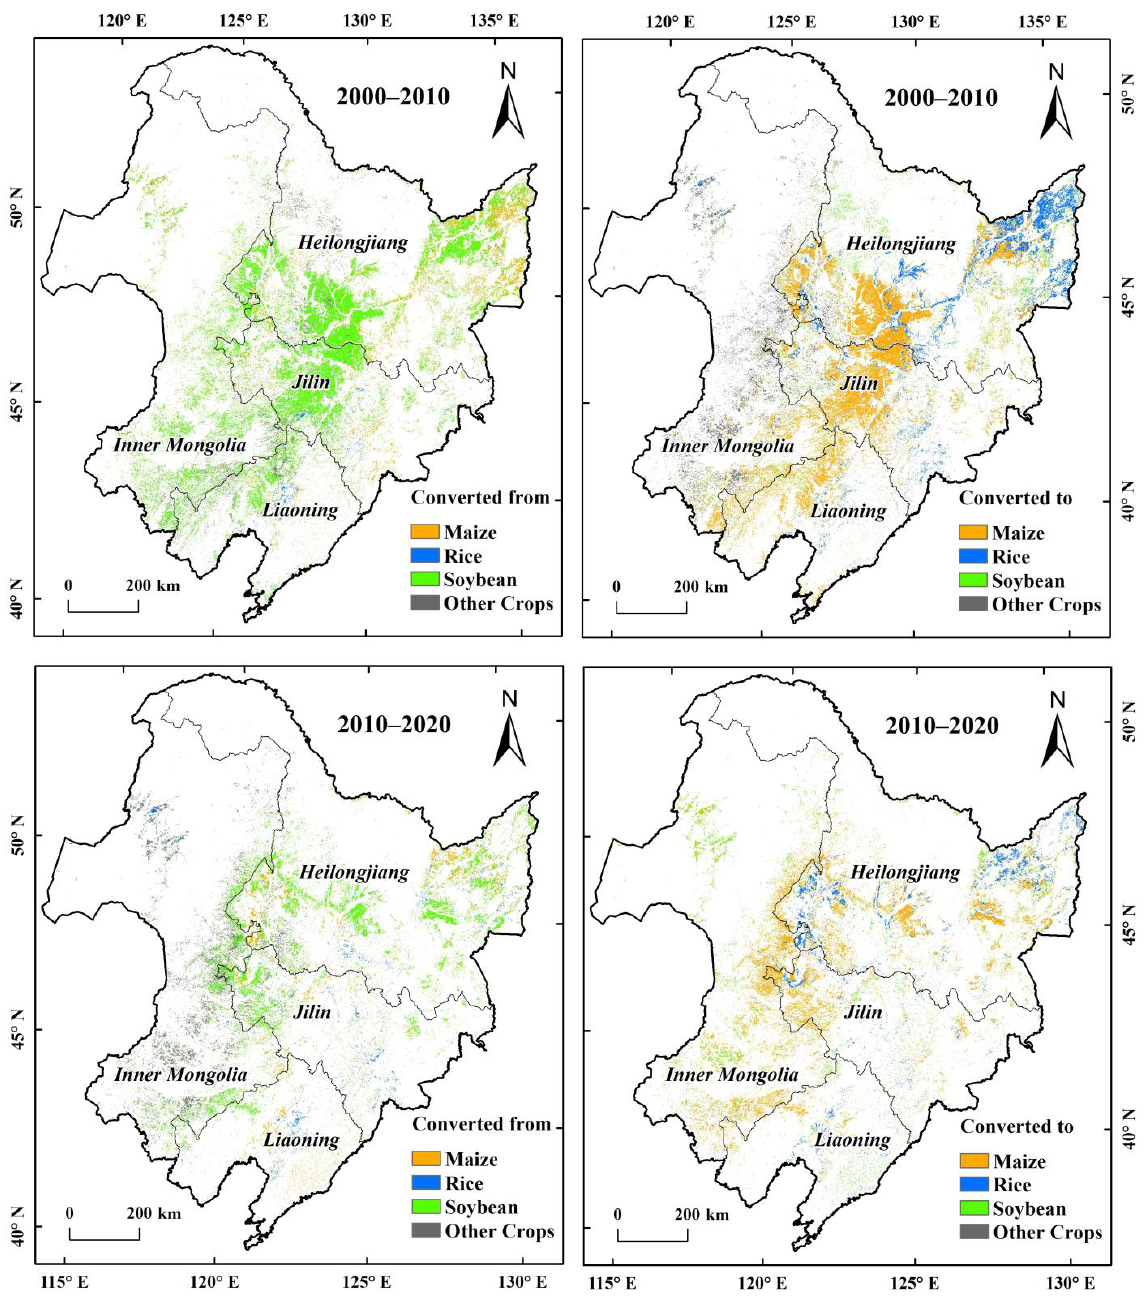
Figure 8. Spatiotemporal crop type conversions in the NEC during 2000 – 2020.